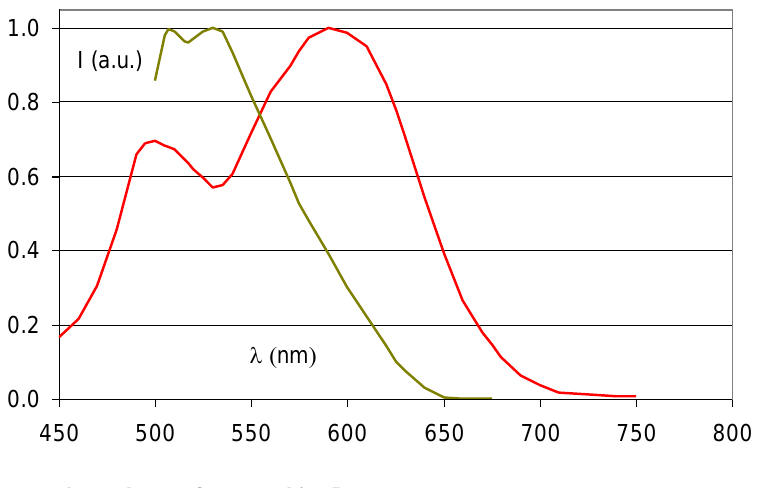
Figure 18. Stimulation spectrum of SrFBr:Eu 2+ (green) (data from [40]) and BaFBr:Eu 2+ (red). I